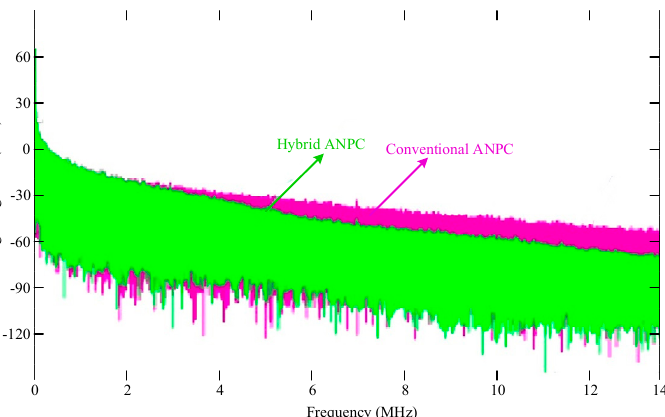
Figure 13. High-frequency voltage spectrum of the conventional ANPC and hybrid ANPC. The cross-sectional area ( A ) of an EMI Filter for the hybrid ANPC with 100 kHz switching frequency can be determined by: